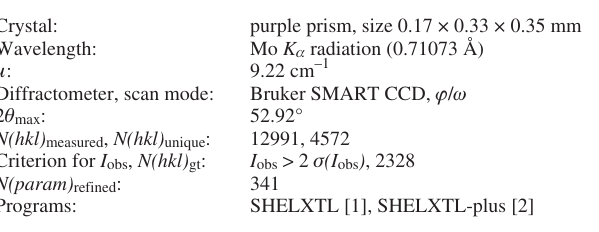
Table 1. Data collection and handling.